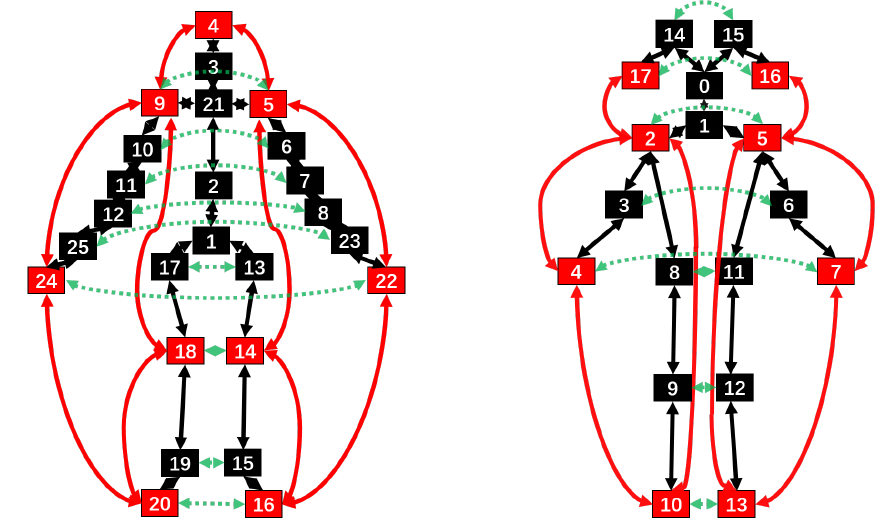
Figure 2. The connection structure of the skeleton graphs in the whole graph convolution network (WGCN). The left graph represents the skeleton graph of the NTU RGB+D 60 and NTU RGB+D 120 datasets, and the right graph represents the skeleton graph of the Kinetics Skeleton dataset. The number on the joints represents the joints labels. The black joints represent the ordinary joints; the red joints represent the edge joints; the black connection between the two joints’ vertexes represents the physical structure connection; the red connection between the two edge joints represents the edge connection; the green connection between the two symmetric joints represents the symmetric